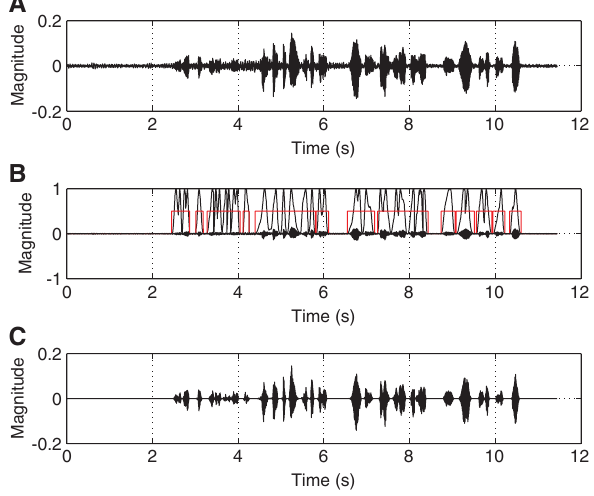
Figure 6. Performance of EMD-Based VAD for Realistic Speech.